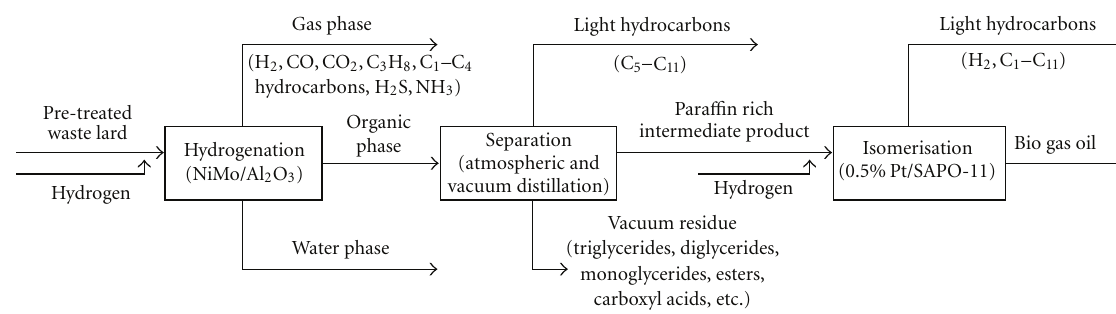
Figure 1: The scheme of the laboratory scale production of the bio gas